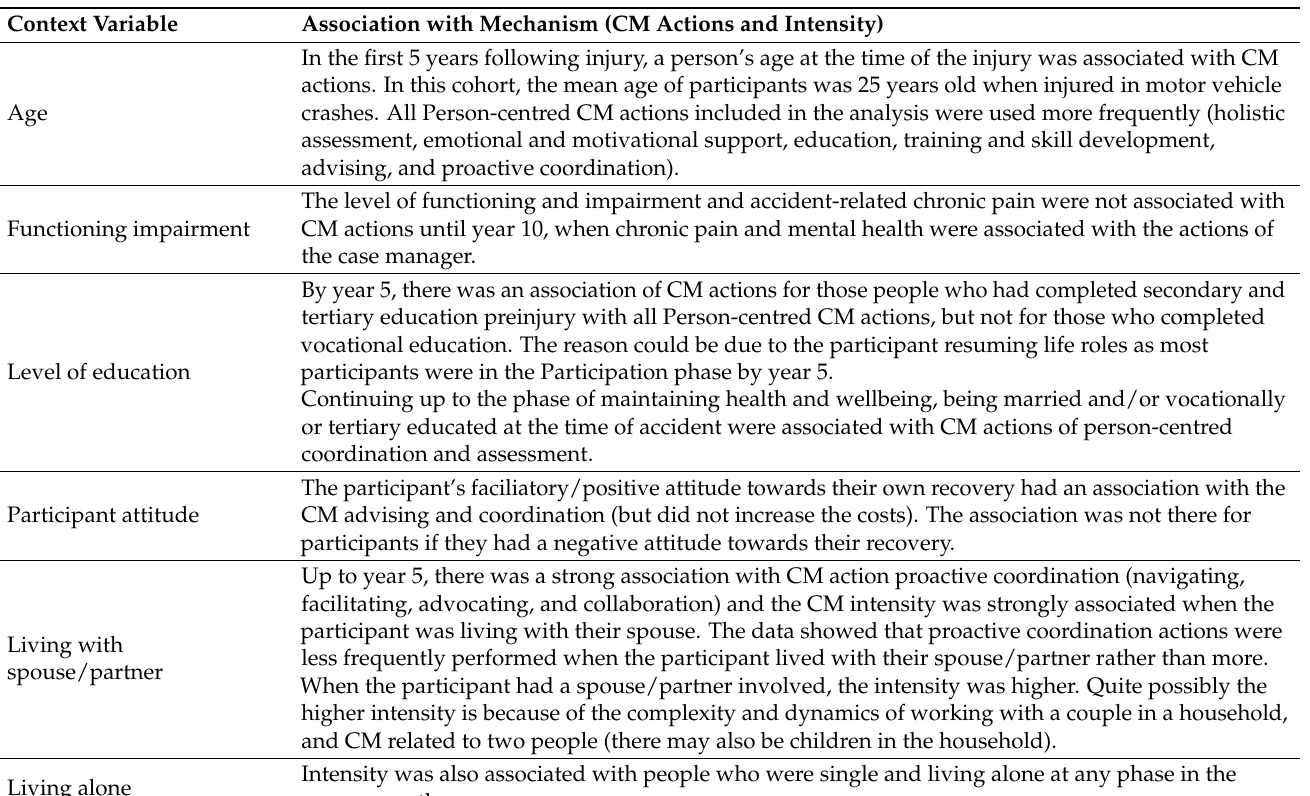
Table 4. SOMNet Results TBI cohort association of context with mechanism variables (weighting >